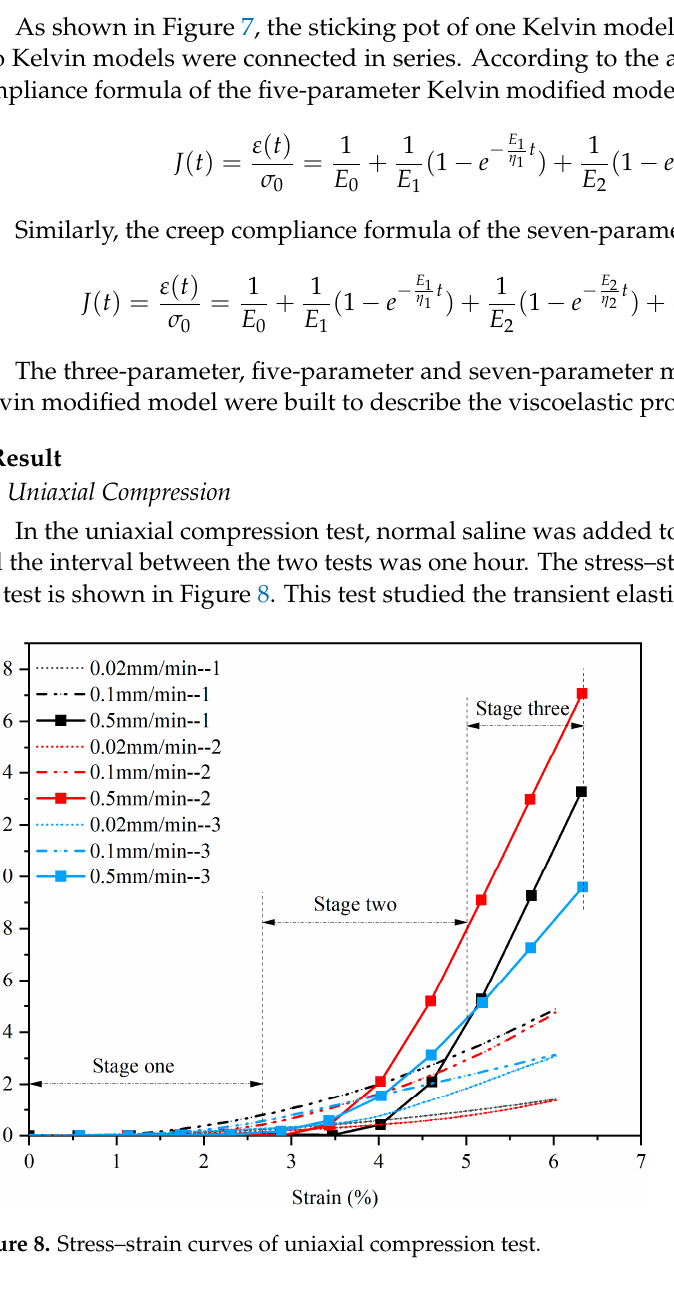
Figure 7. ( a ) Five-parameter Model, ( b ) Seven-parameter model.